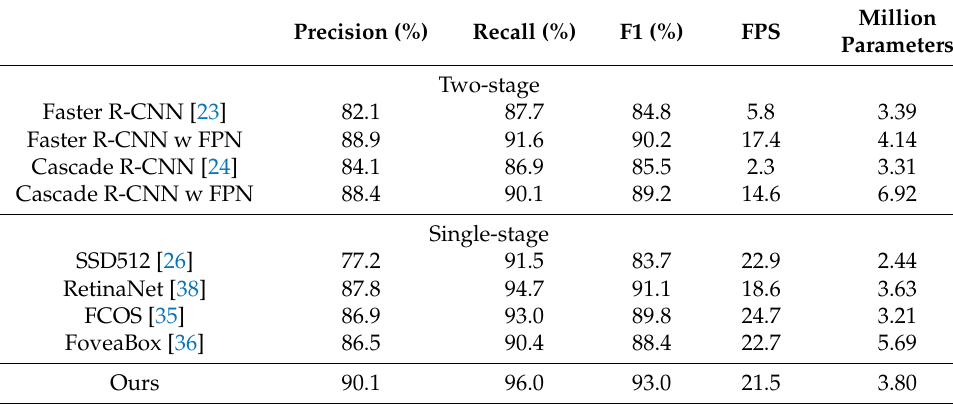
Table 2. Comparison of multiple detection methods in